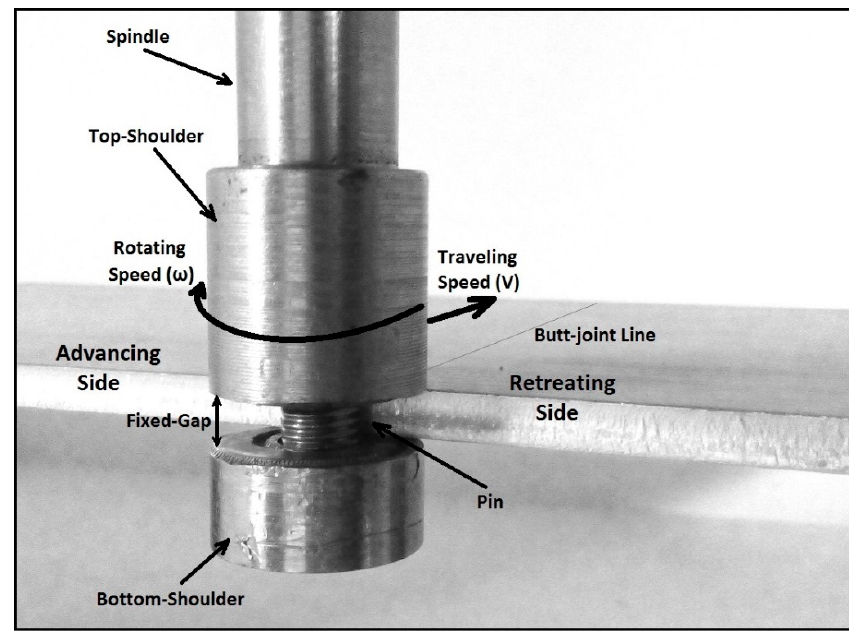
Figure 1. Schematic of the BFSW process for a butt-joint position.